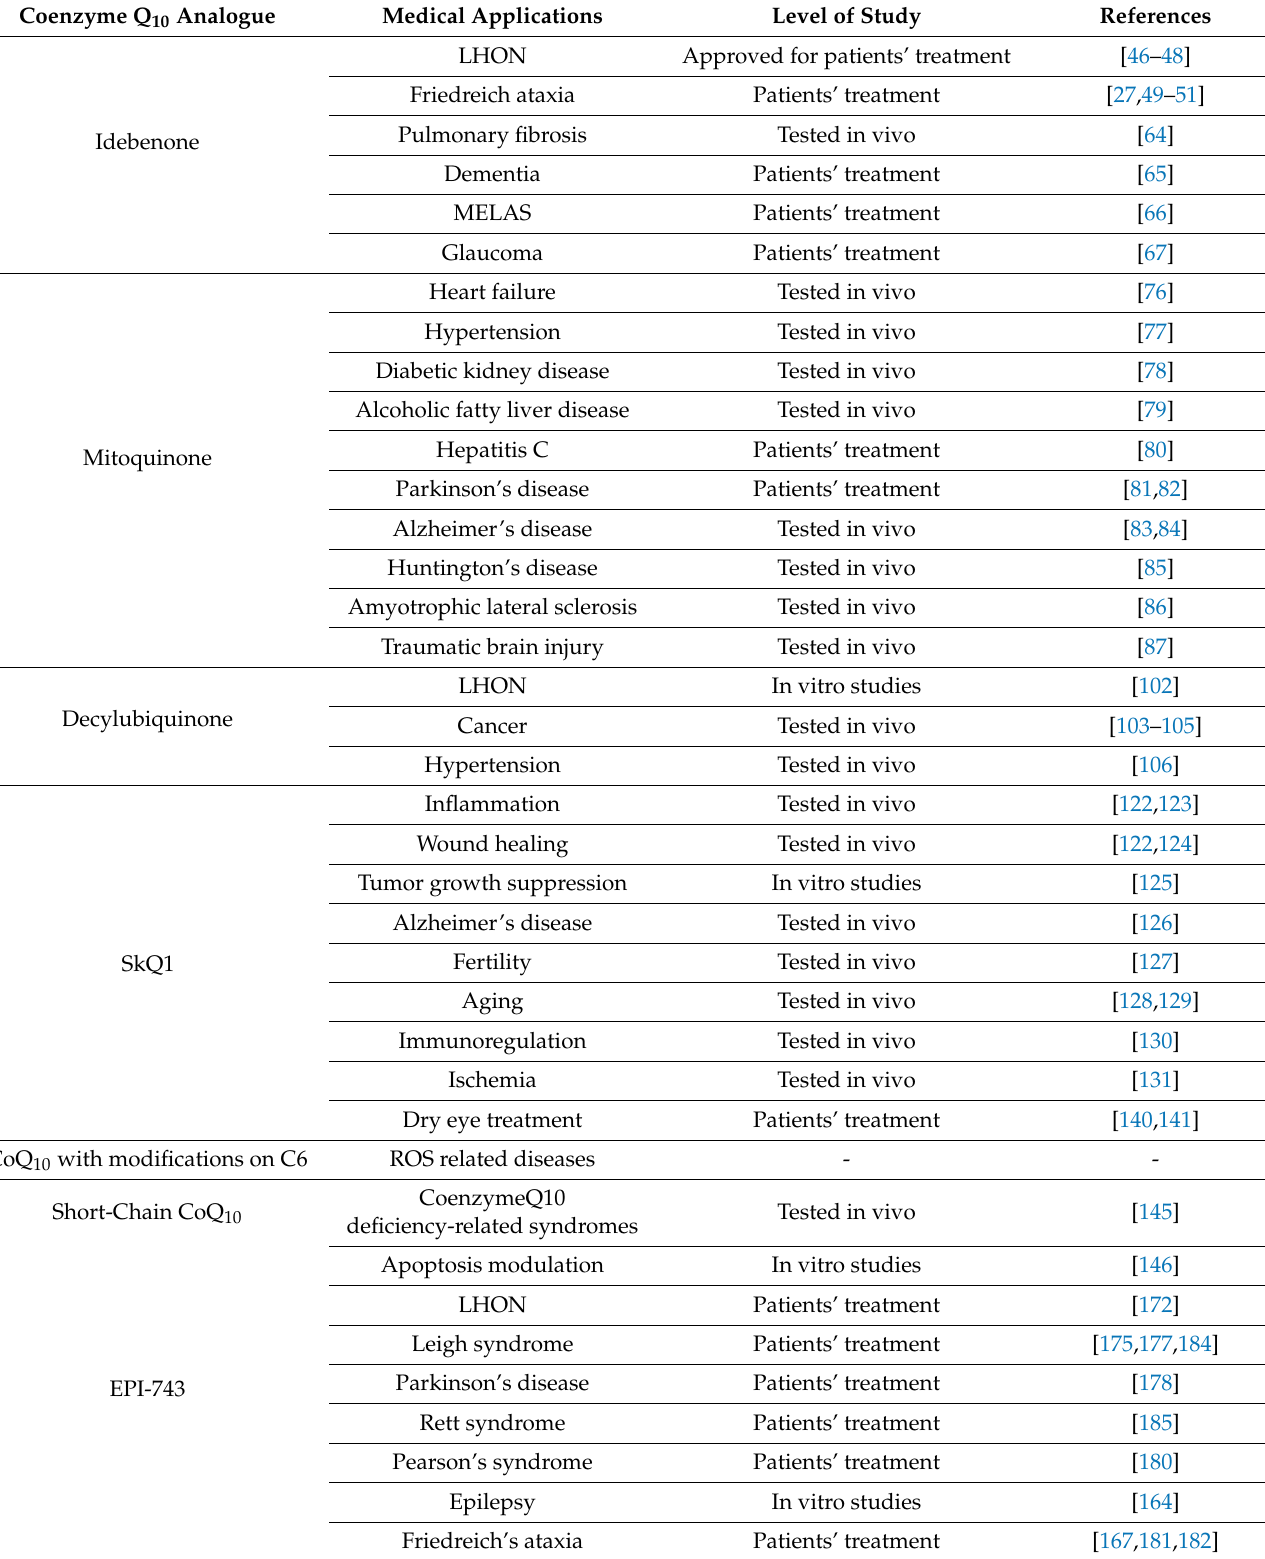
Table 1. Coenzyme Q 10 analogues and their